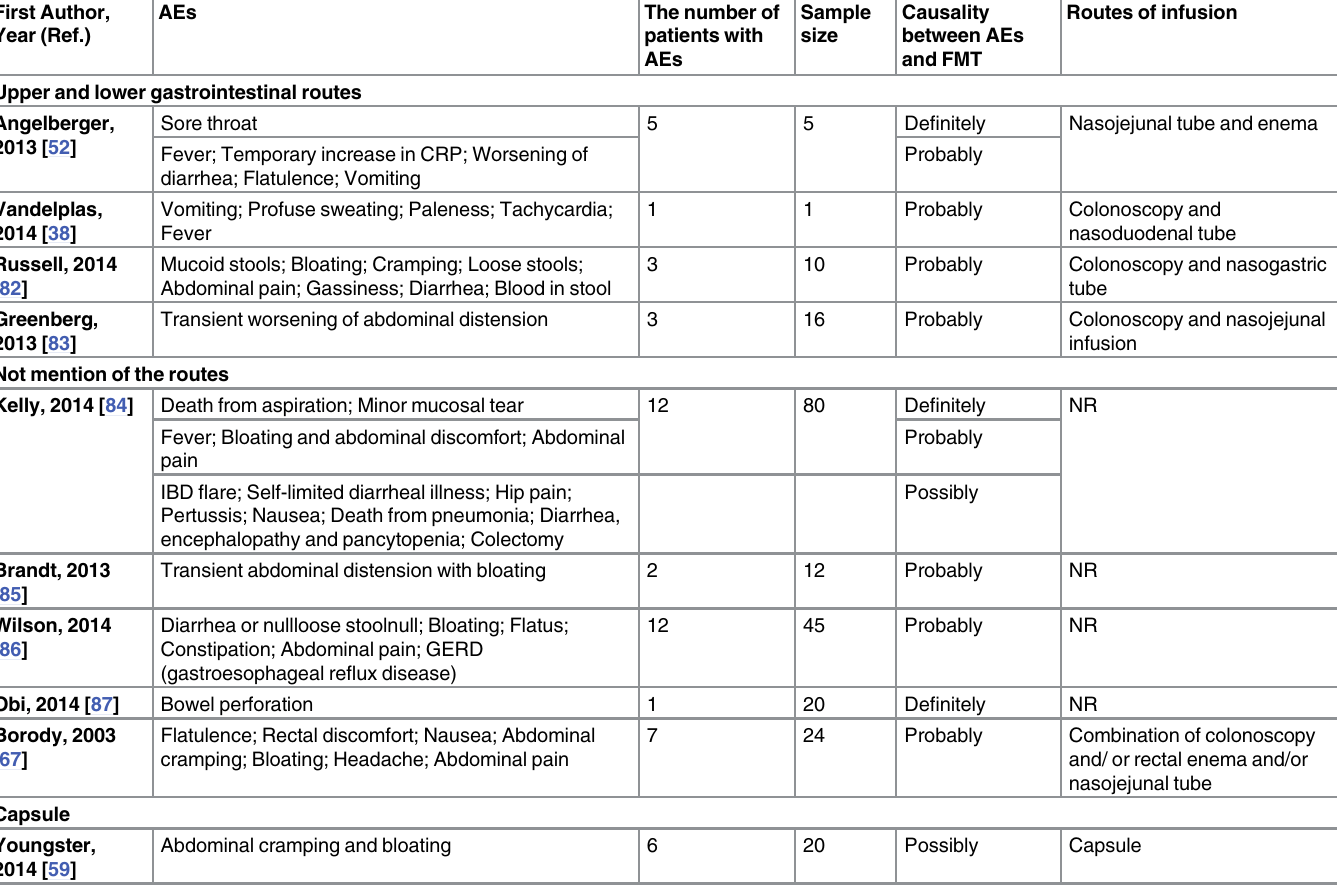
Table 3. Attributable adverse events are grouped by route of administration (Upper and lower gastrointestinal routes; Not mention of the routes; Capsule). First Author, Year